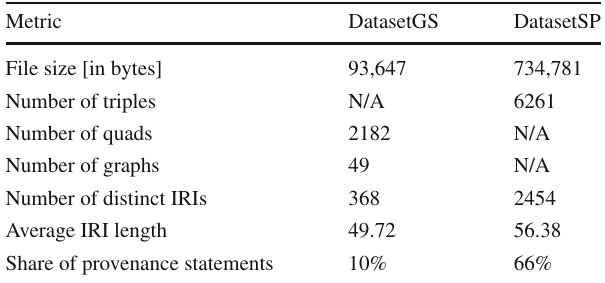
Table 10 Metrics-based comparison between implementations of GraphSource (DatasetGS) and singleton property (DatasetSP) Metric